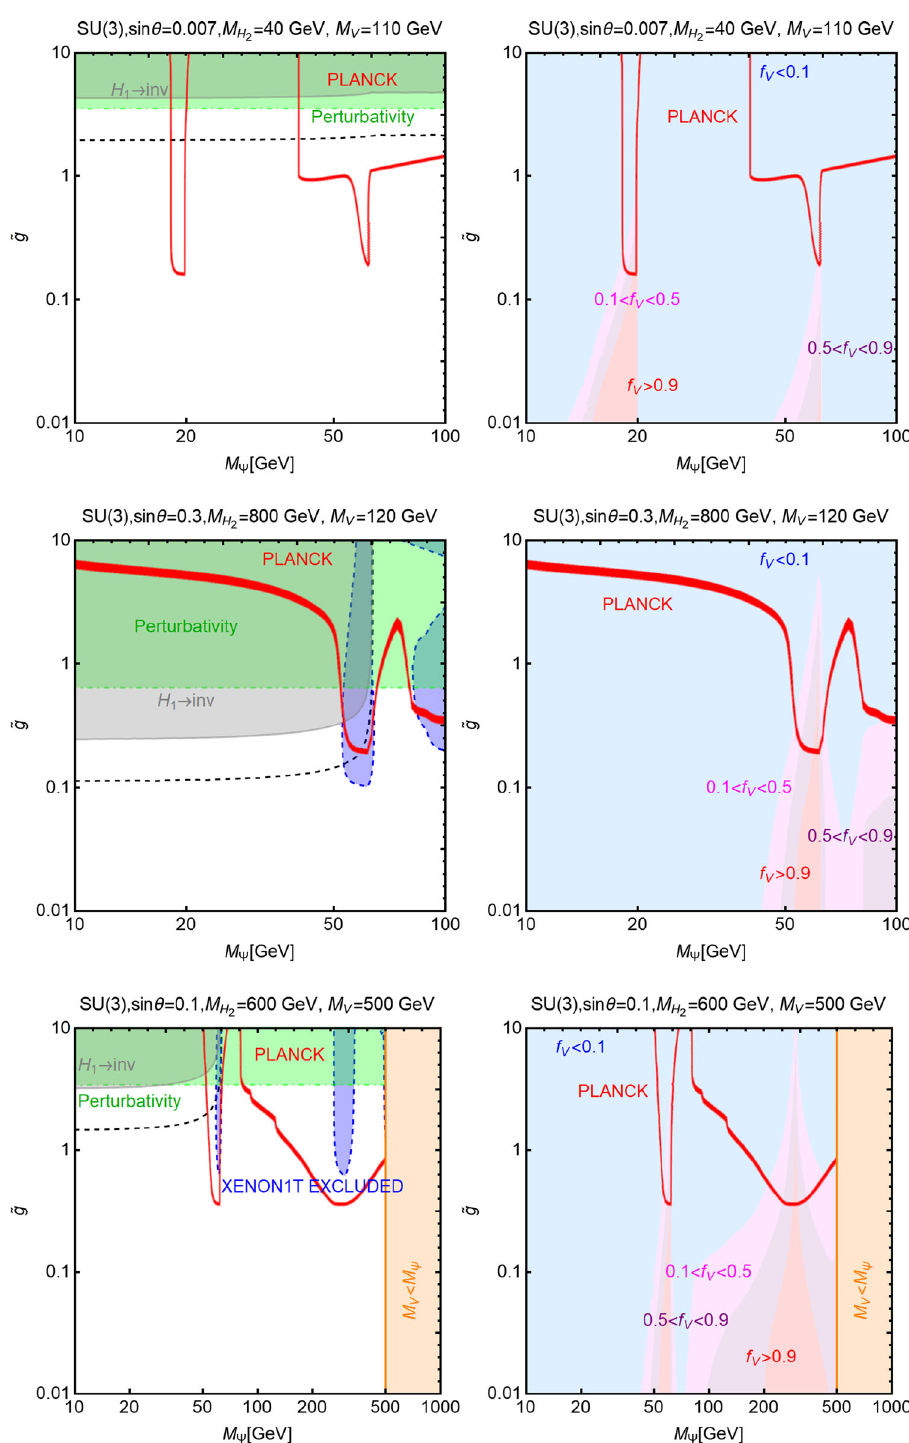
Fig. 25 Left column: combined constraints in the [ M Ψ , ˜ g ] plane for three benchmarks of the dark SU(3) model with V /Ψ double component DM; the other model parameters have been fixed as indicated on the top of the panels. Right column: relative contributions, measured through the parameter f V = Ω V /Ω tot , of the two DM components to the relic density, for the same benchmarks. The colored regions represent the of values for f V , f V > 0 . 9, 0 . 5 < f V < 0 .